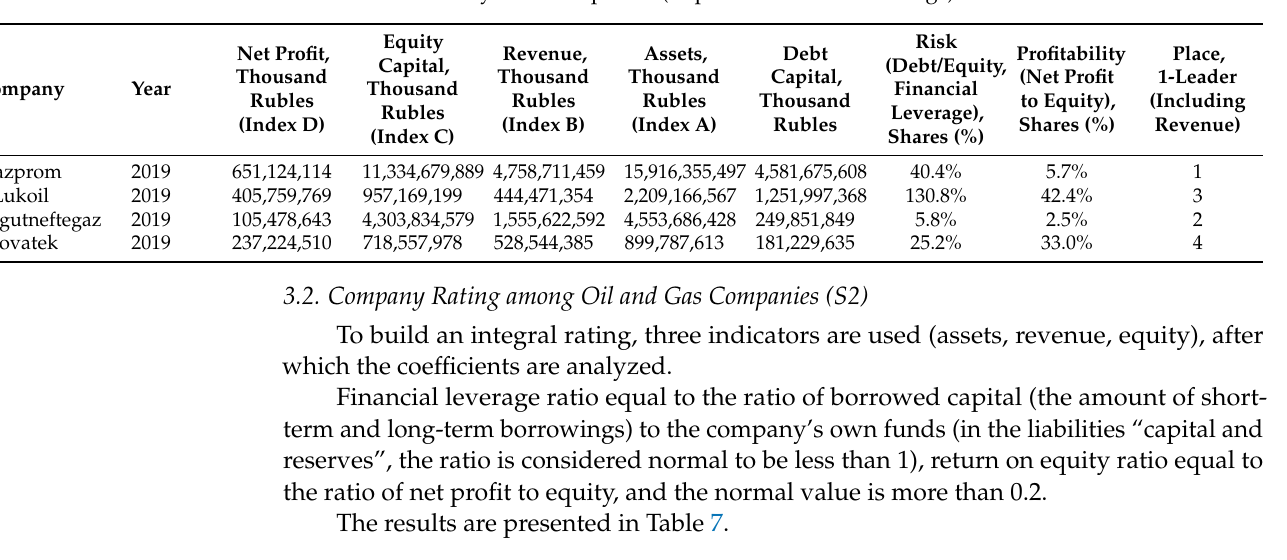
Table 7. Financial analysis of companies (important ratios and ratings).